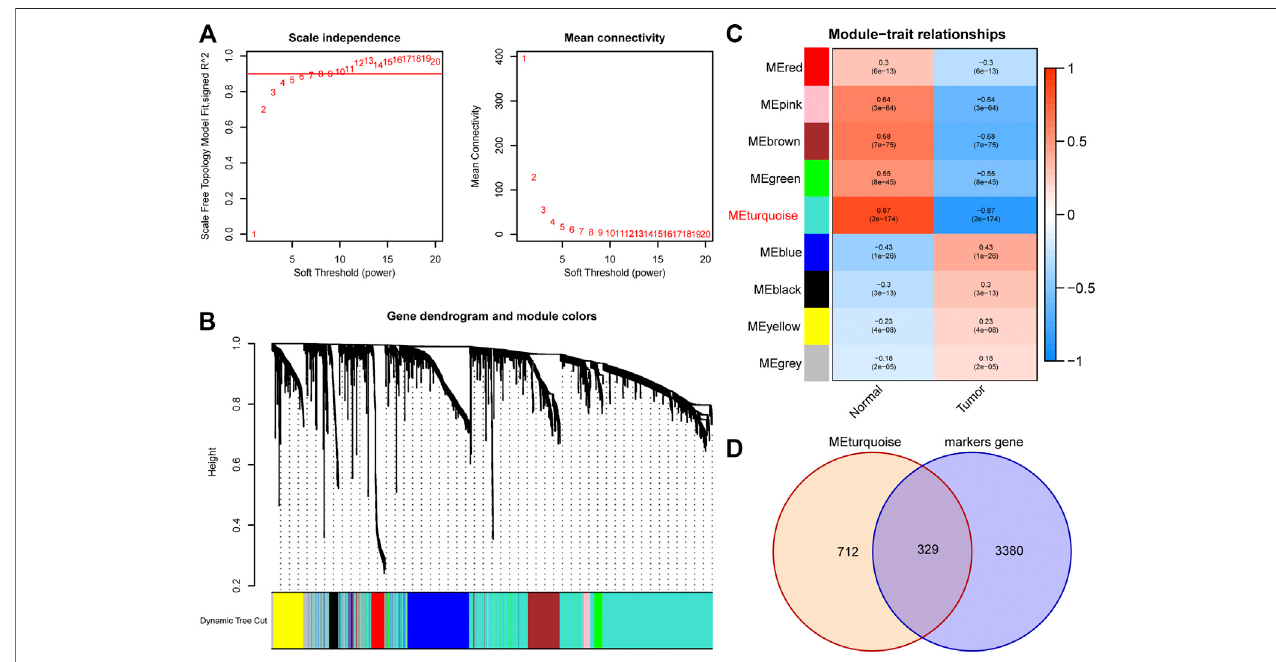
FIGURE 3 | Identi fi cation of hub DEGs that participate in LUAD development through WGCNA. (A) The scale-free fi t index for soft thresholding powers. The soft thresholding power β in the WGCNA was determined based on a scale-free R 2 ( R 2 = 0.90). The left panel illustrates the relationship between β and R 2 . The right panel illustratestherelationshipbetween β andmeanconnectivity. (B) AdendrogramoftheDEGsclusteredbasedondifferentmetrics. (C) Aheatmapillustratesthecorrelation between different gene modules and clinical traits (normal vs. tumor); (D) The Venn plot to identify common DEGs between WGCNA module genes and marker genes. DEGs, differentially expressed genes; LUAD, lung adenocarcinoma; WGCNA, Weighted Gene Correlation Network Analysis.